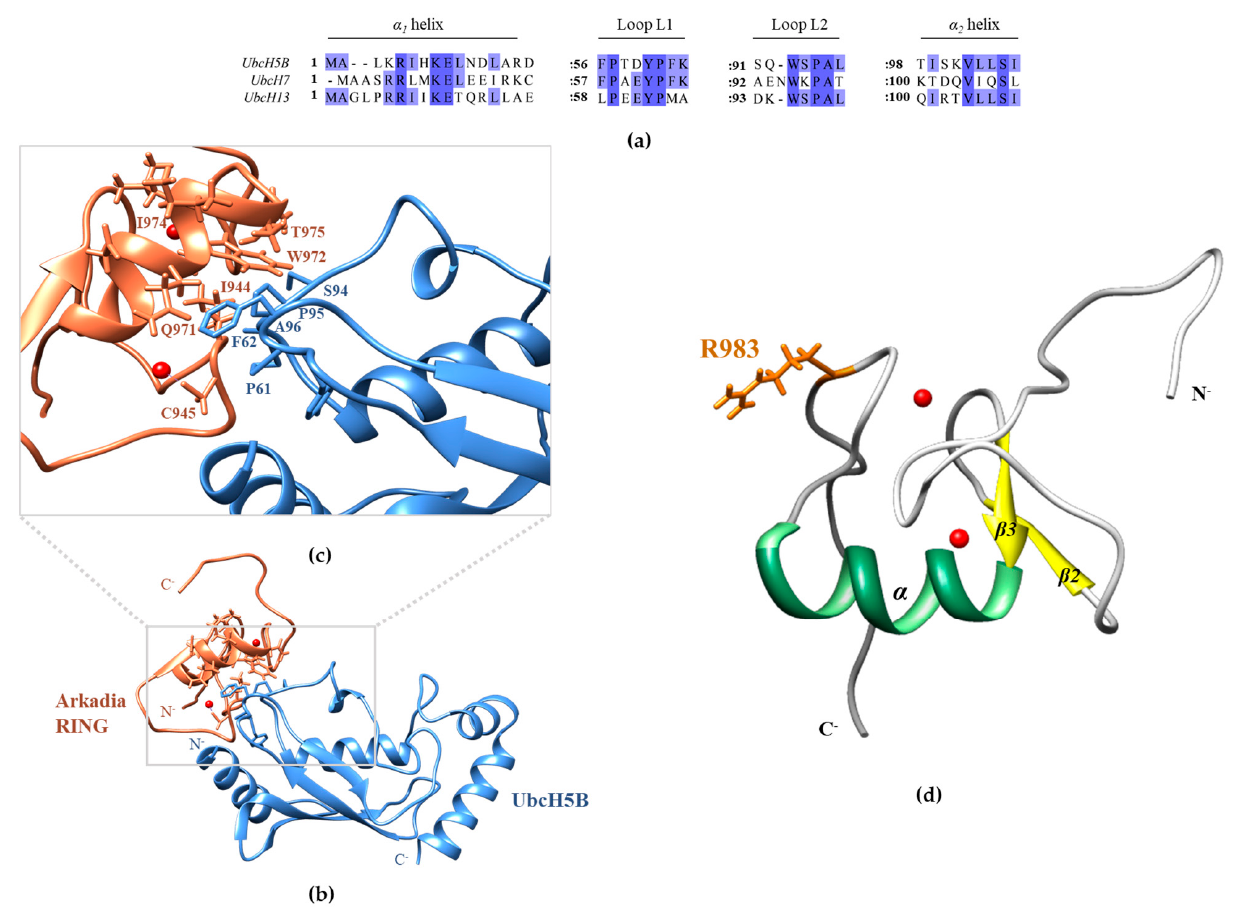
Figure 9. ( a ) Sequence alignment of helix a 1 , loop L1, loop L2, and helix a 2 of UbcH5B, UbcH7, and UbcH13 E2 enzymes, showing the amino acid conservation among the interacting with Arkadia regions. ( b ) Model of the UbcH5B–Ark RING complex (UbcH5B in light blue and Ark RING in coral). The model was prepared by superimposing Ark RING (PDBid: 2KIZ) to the X-ray structure of the UbcH5B-c-CBL complex (PDBid: 4A49) and extracting the c-CBL structure. Zn(II) ions are depicted as red spheres. ( c ) Close-up of the theoretical UbcH5B–Ark RING interface highlighting the central role of UbcH5B’s Phe62 and Ser94-Pro95-Ala96 motif. Key contact residues from Arkadia and UbcH5B are shown as coral and light blue sticks, respectively. ( d ) NMR structure of Ark RING (PDBid: 2KIZ) with Arg983 shown in orange sticks.